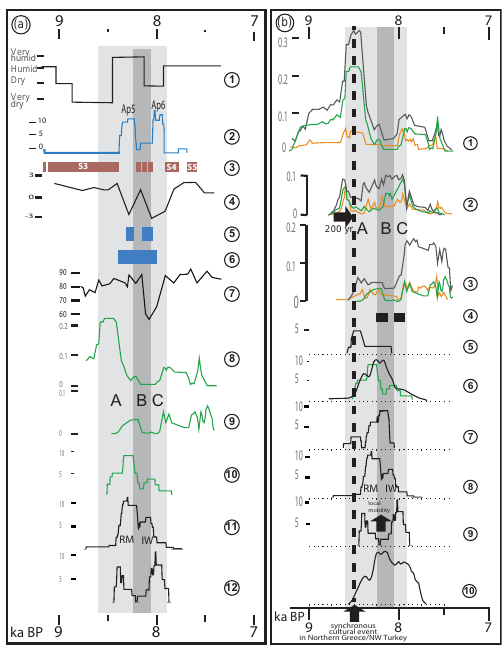
Figure 12. (a) Comparison of regional hydroclimatic pattern for Anatolia and Northern Aegean areas with micro-regional and main sites cumulative probability density: 1, endorheic plains of central Anatolia (Kuzucuoglu, this paper); 2, gully erosion/fluvio-colluvial aggradation in Sidari 1/2 (Berger, this paper); 3, soil formation in Sidari 1/2 (Berger, this paper); 4, Lake Maliq pollen-based temper- ature of the coldest month (Albania; Bordon et al., 2009); 5, on- colith deposits in Dikili Tash swamp (Macedonia; Lespez et al., this paper); 6, detritism in Lake Dojran (Macedonia) (Zhang et al., 2014); 7, Tenaghi Philippon tree pollen (%) (Macedonia; Pross et al., 2011); 8, central Anatolian late Neolithic sites (short-lived dates, n = 123); 9, northwestern Turkey (short-lived dates, n = 83); 10, Nea Nikomedia (Macedonia)(12 short-lived dates) (Pyke and Yiouni, 1996); 11, Sidari (Corfu) (12 charcoal, 3 short-lived dates (Berger et al., 2014) and in progress; RM: red monochrome ware; IP: Impressa ware); 12, Dikili Tash (11 charcoal dates) (Macedonia; Lespez et al., 2013). (b) Comparison of time dynamic of Neolithisa- tion from central Anatolia to Corfu: 1, central Anatolia, all n = 285, short-lived n = 123 (after Flohr et al., 2016); 2, western Anatolia, all n = 64, short-lived n = 31 (after Flohr et al., 2016); 3, northwest- ern Turkey, all n = 136, short-lived n = 83 (after Flohr et al., 2016); 4, strong decline of site occupation in Tell Sabi Abyad (northern Syria) (from Weninger et al., 2014); 5, Paliambala (five dates, af- ter Karamitrou-Mentessidi et al., 2013); 6, Nea Nikomedia, Thes- saly (16 dates; Weninger et al., 2006) (12 dates, “short-lived”; Pyke and Yiouni, 1996); 7, Mavropigi-Filotsairi, Macedonia (12 dates, after Karamitrou-Mentessidi et al., 2013); 8, Sidari, Corfu (15 dates (Berger et al., 2014) and in progress; RM: red monochrome; IP: Impressa ware); 9, Dikili Tash, Macedonia (11 dates) (Lespez et al., 2013); 10, Achilleion, Thessaly (44 dates) (Weninger et al.,